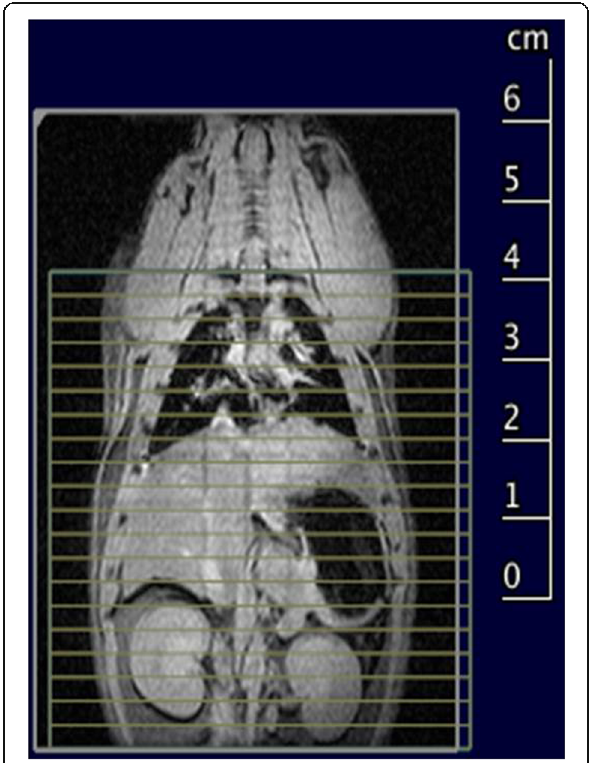
Fig. 2 Slice geometry of the 19 F rapid acquisition with refocused echo (RARE) sequence visualised onto a multiplane multislice localiser sequence of a non-injected